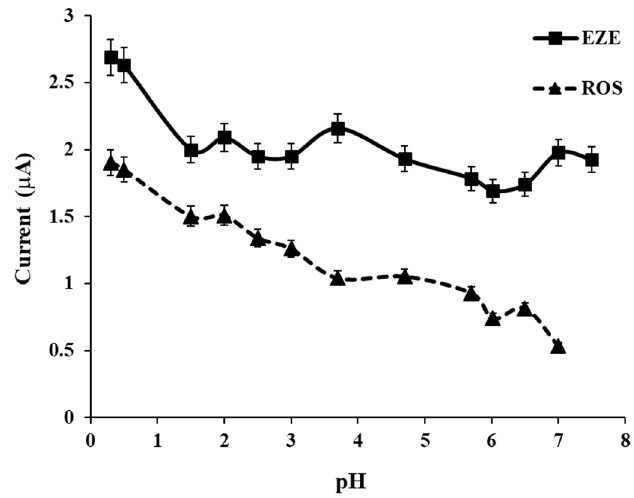
Figure 2. Plot of I p vs. pH of 1 × 10 − 4 M ROS and EZE solution using the DPV.